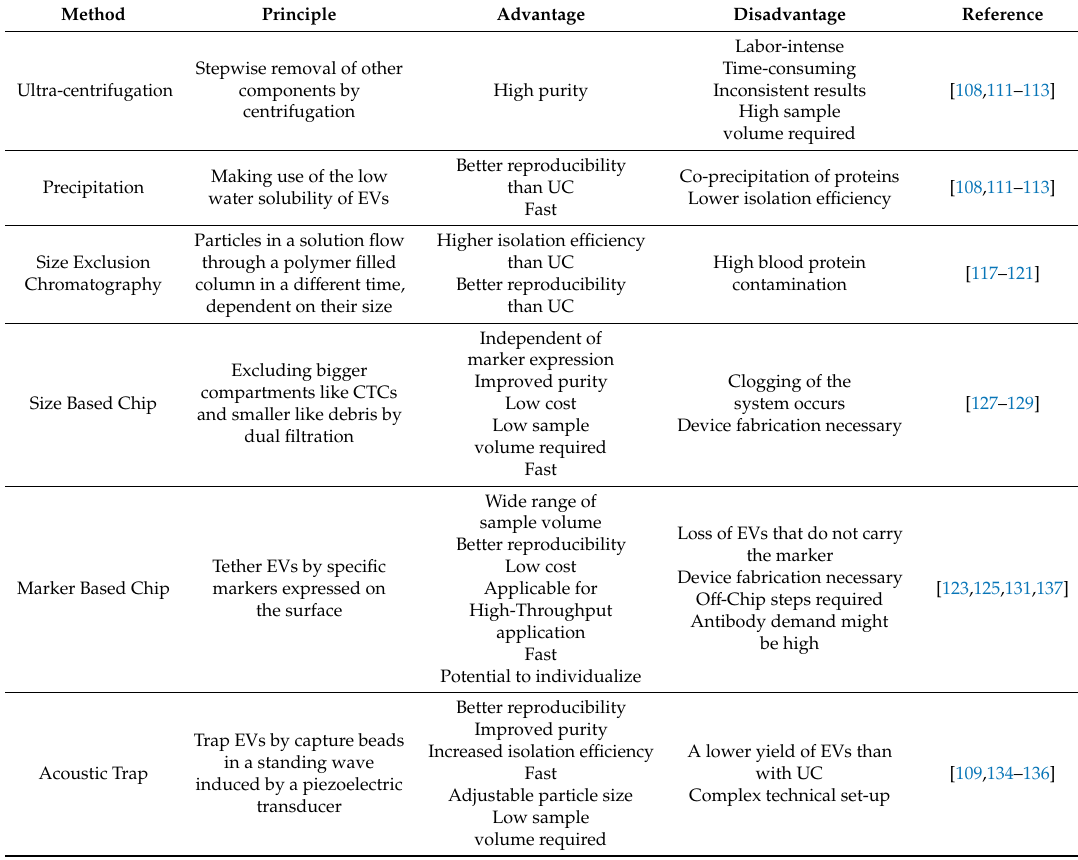
Table 2. Overview of the advantages and disadvantages of described EV isolation